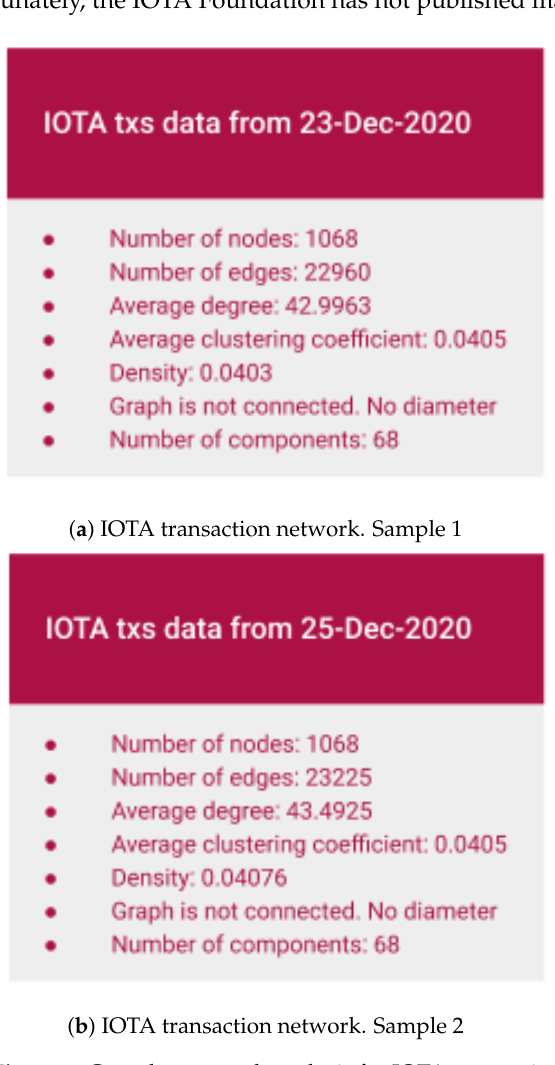
Figure 8. Complex network analysis for IOTA